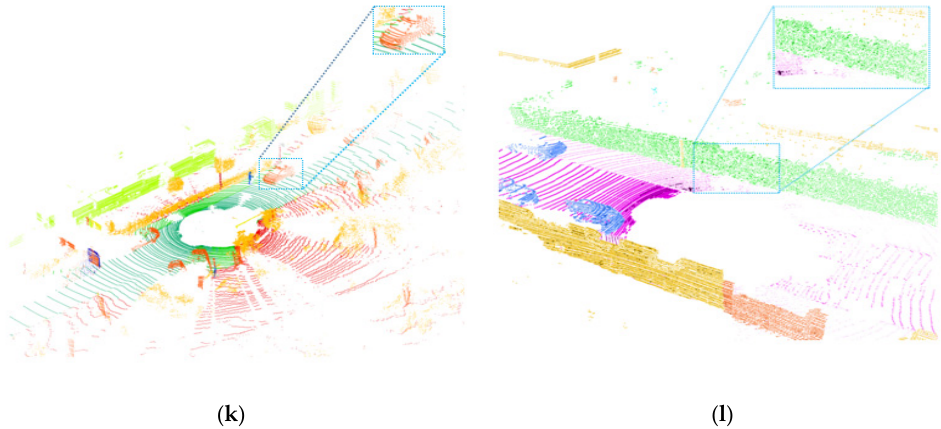
Figure 5. Semantic segmentation results by using the proposed DGPolarNet method on the SemanticKITTI: ( a ) Trunk; ( b ) Bicyclelist; ( c ) Fence; ( d ) Bus; ( e ) Truck; ( f ) Bicycle; ( g ) Person; ( h ) Pole; ( i ) Traffic-sign; ( j ) Building; ( k ) Car; ( l ) Vegetation. Table 2. The IoU performances on SemanticKITTI compared with the typical semantic segmentation methods. Per Class IoU Ground-Related Structures Model